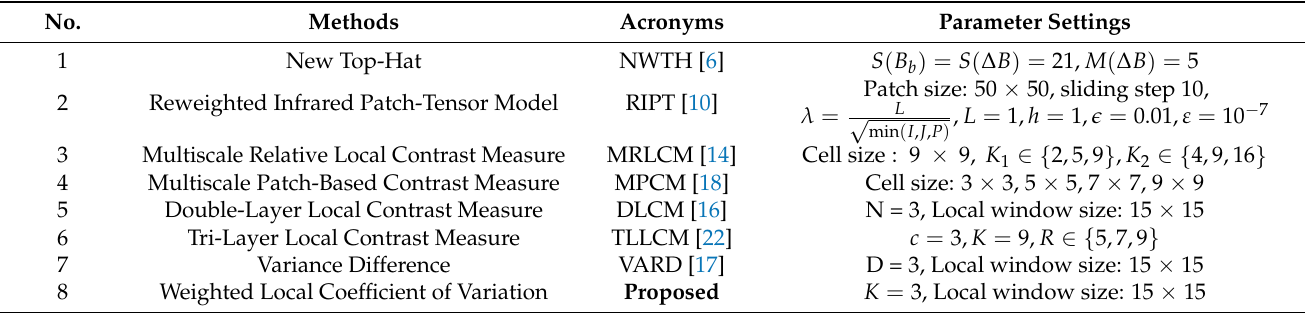
Table 1. Parameter values used in the